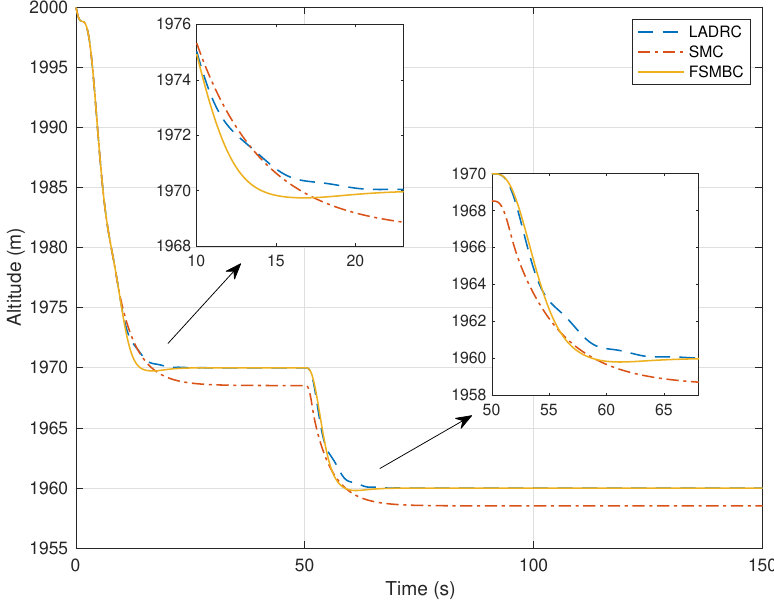
Figure 10. Simulation results of altitude cotrol by LADRC, SMC, and FSMBC for variable altitude